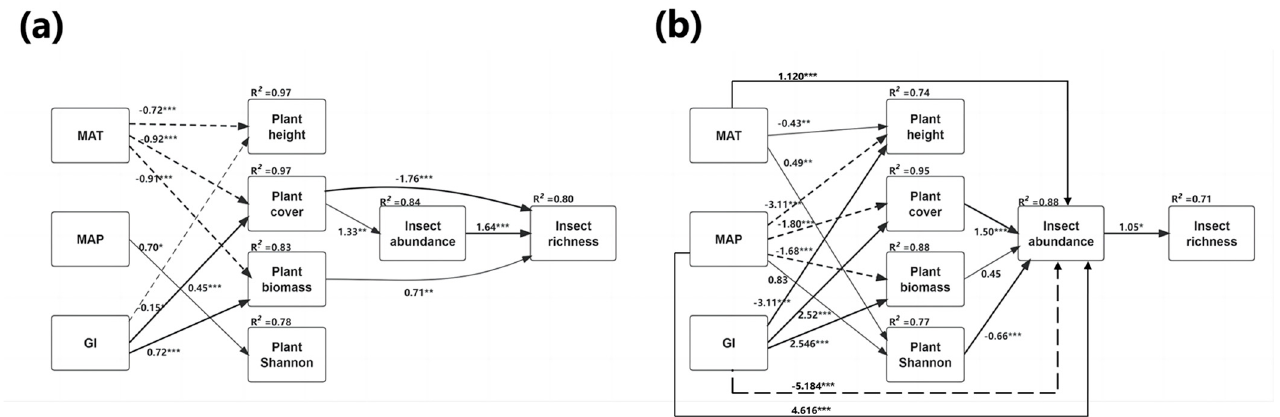
Figure 5. Path diagram for the structural equation model (SEM) for environmental factors on insect abundance and species richness in ( a ) typical steppe and ( b ) desert steppe. Statistically significant positive paths are indicated by solid arrows. Statistically significant negative paths are indicated by dashed arrows. The R 2 values in each box indicate the amount of variation in that variable explained by the input arrows. Numbers next to arrows are unstandardized slopes. p -values significance level is < 0.05. * p ≤ 0.01, ** p ≤ 0.001, and *** p ≤ 0.0001.